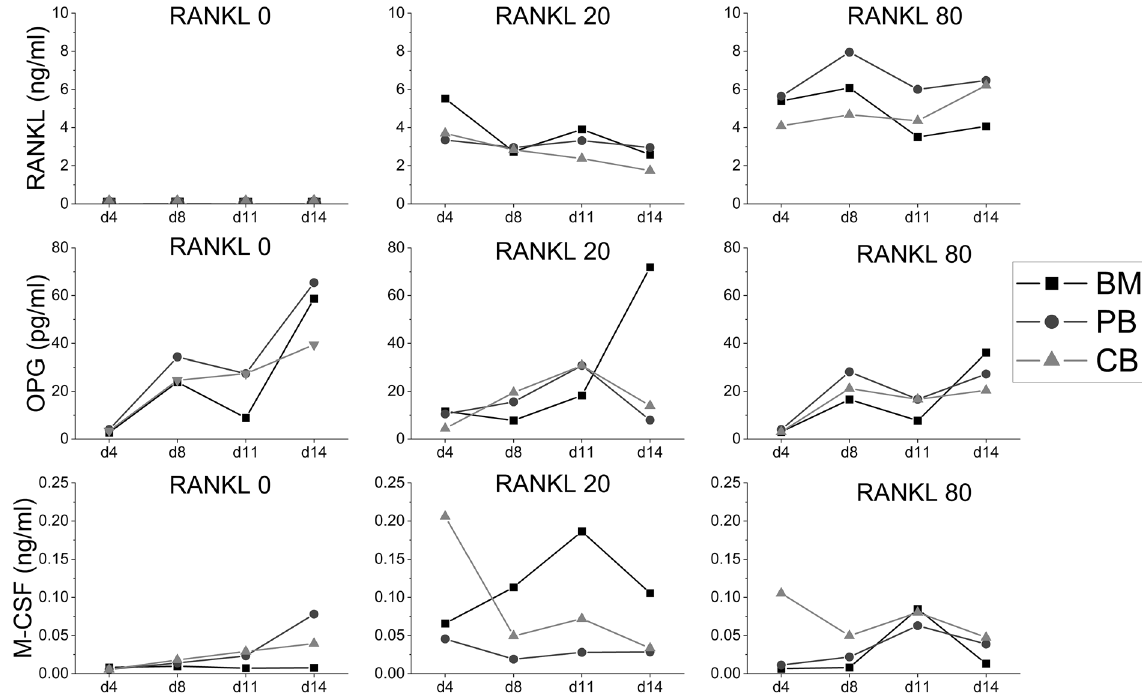
Figure 4. Cytokine concentrations in BM, PB and CB cultures at timepoints d4, d8, d11 and d14. RANKL numbers indicate the concentration of RANKL (ng/ml) added to the cell culture. Cell culture media were collected on the above-mentioned timepoints and analyzed with custom ProcartaPlex panel for RANKL, M-CSF and OPG. The data in the graph is pooled from 4 patients per culture type and shown as mean ± SEM.